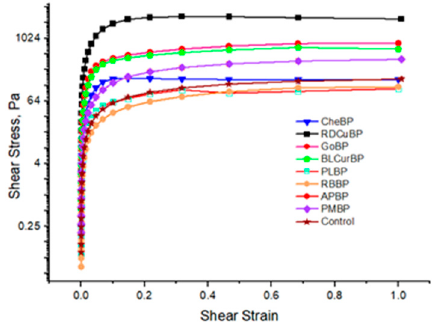
Figure 4. Shear stress of gels from BPP and Control (Sigma Aldrich AP).